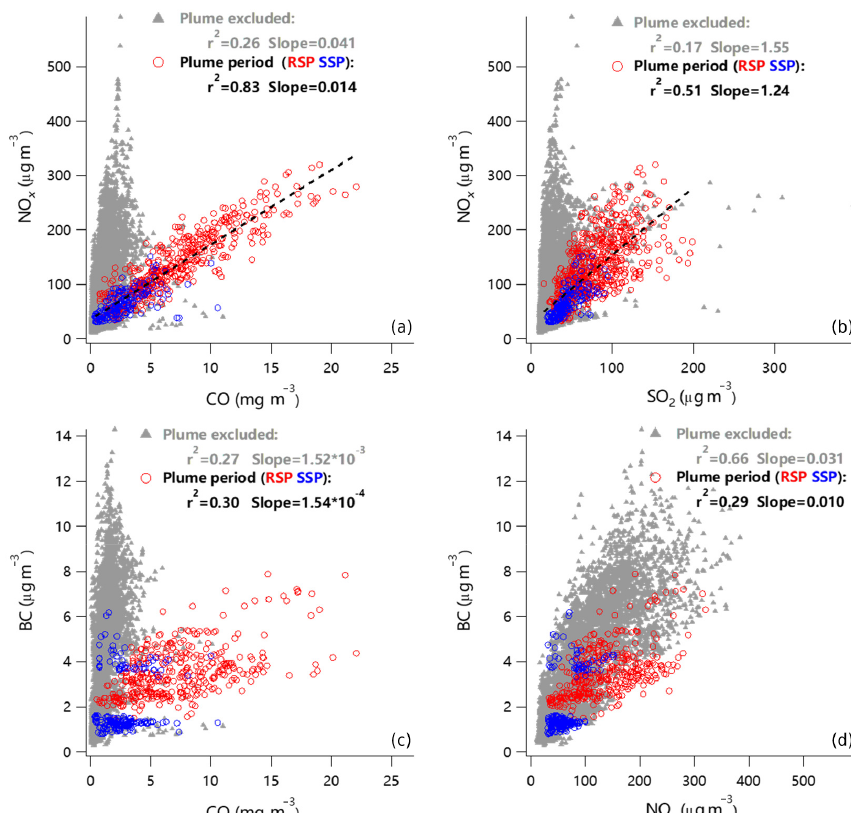
Figure 8. Correlations between (a) NO x and CO, (b) NO x and SO 2 , (c) BC and CO, and (d) BC and NO x during periods with (open circles) and without (gray triangle) influences of the emissions from the steel plants. RSP is the Rizhao steel plant and SSP is the Shandong steel